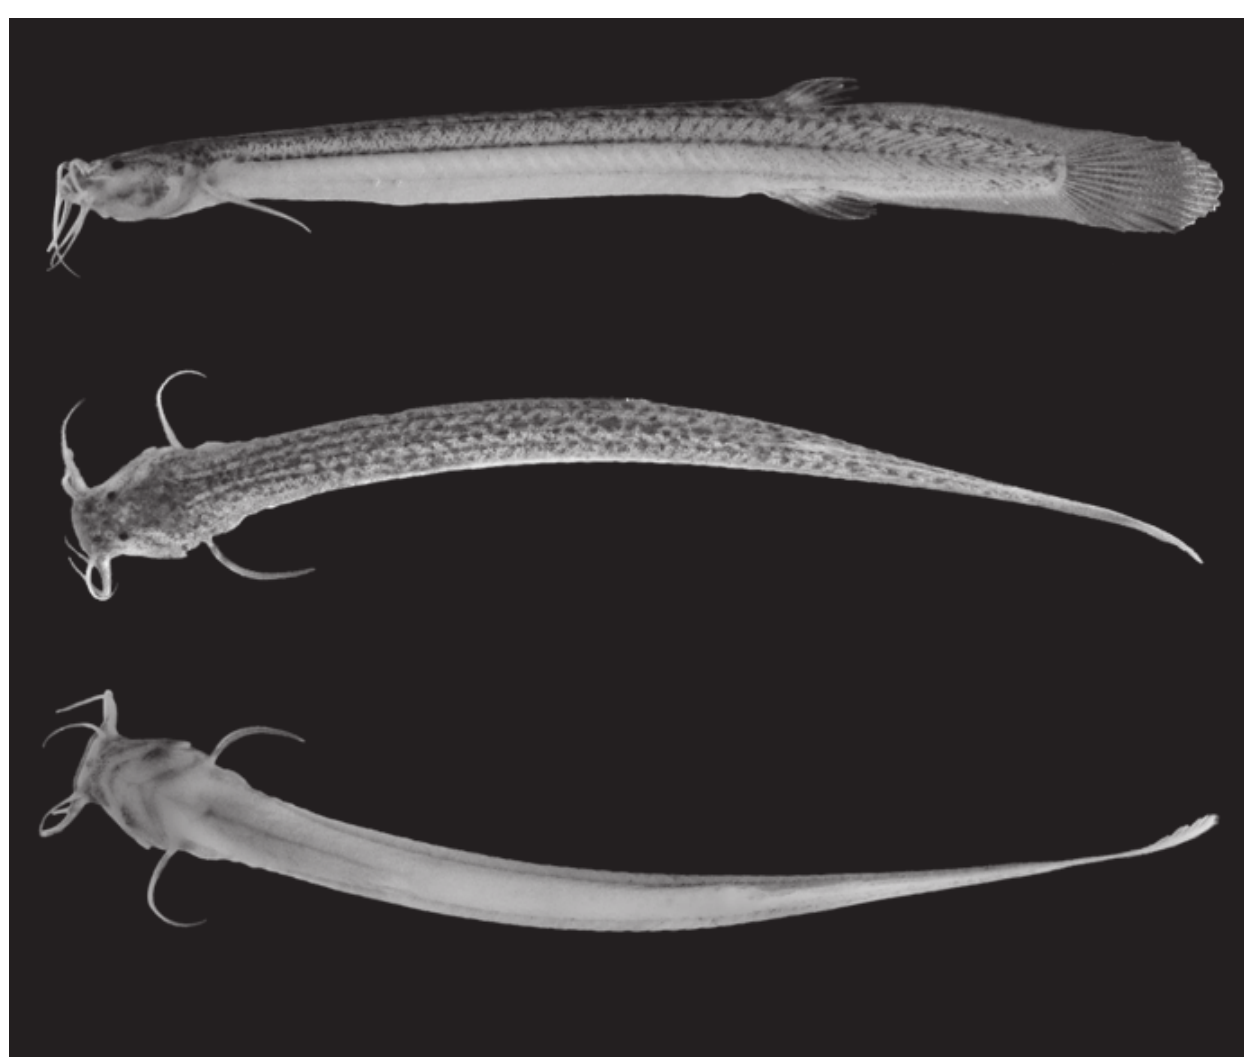
Fig. 2. Listrura costai , new species, holotype, MNRJ 31917, 31.3 mm SL; Brazil, Rio de Janeiro State, Angra dos Reis Municipality, in lateral (above), dorsal (middle), and ventral (below)